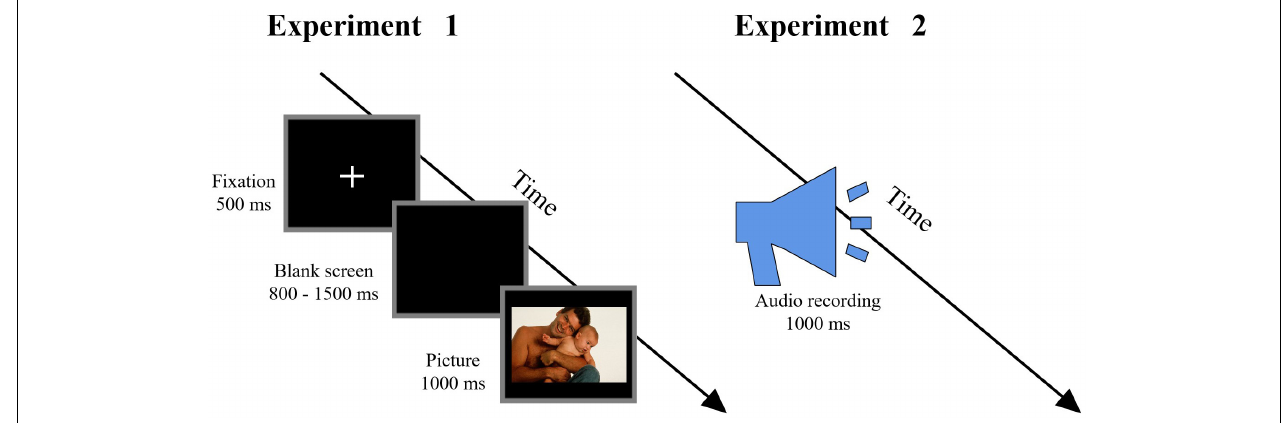
FIGURE 2 | Flowchart describing the experimental design. Left column: Procedure of Experiment 1, in which participants were instructed to passively view the pictures. Right column: Procedure of Experiment 2, in which participants were instructed to passively listen to the audio recordings (Reproduced with permission from Di Yang and Yuanyan